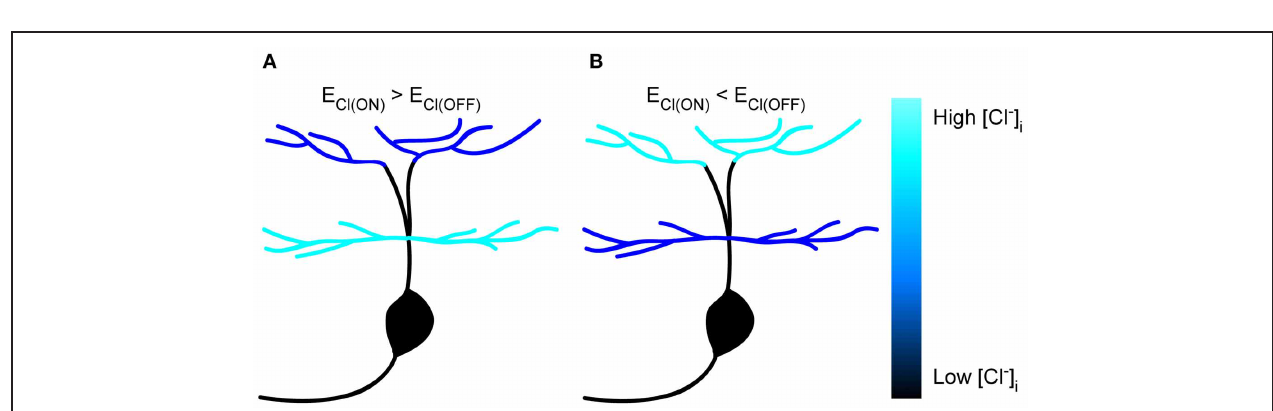
FIGURE 5 | Blockade of KCC2 reduces subcellular E Cl difference. (A,B) Cumulative probability of inter-dendritic (A) and somato-dendritic (B) E Cl difference in control ( n = 44 cells) and furosemide-treated ( n = 29 cells)